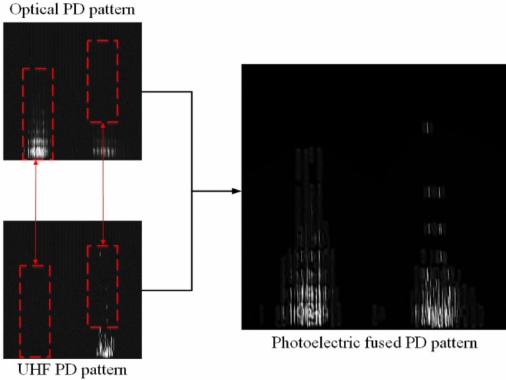
Figure 15. Photoelectric fusion PD